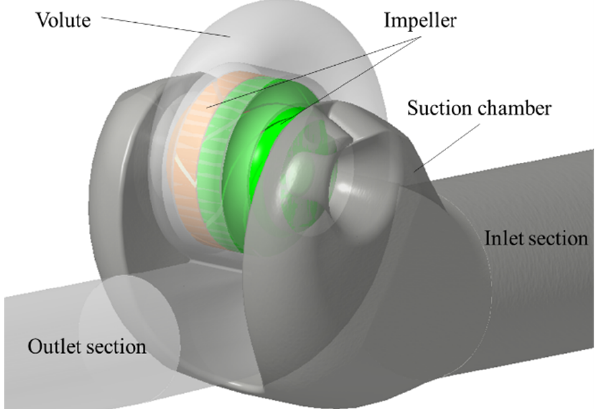
Figure 2. Computational domain of double-suction centrifugal pump.